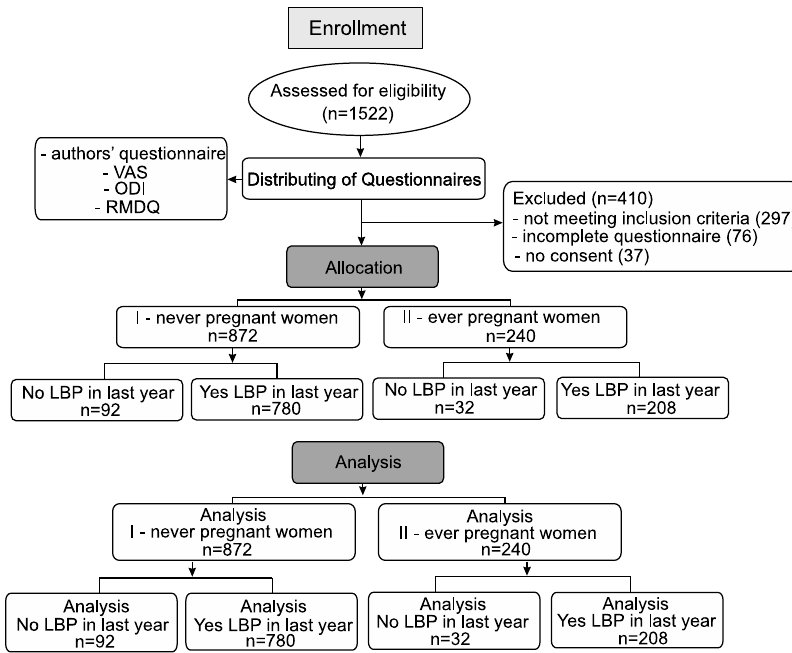
Figure 1. Flowchart of the experimental procedure.